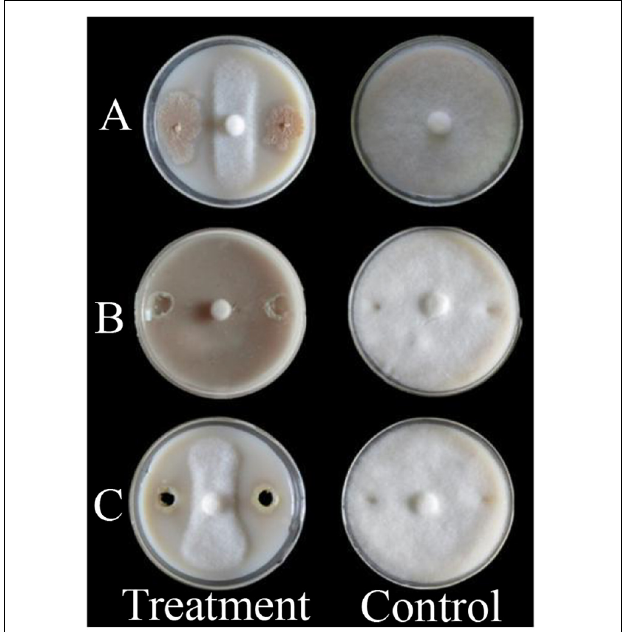
FIGURE 1 | Inhibitory effect of B. megaterium WL-3 against P. infestans mycelium growth. (A) Living cell (LC); (B) Cell suspension (CS); (C) Cell-free supernatant (CFS). Photographs are representative of experiments performed in triplicate, the same below.